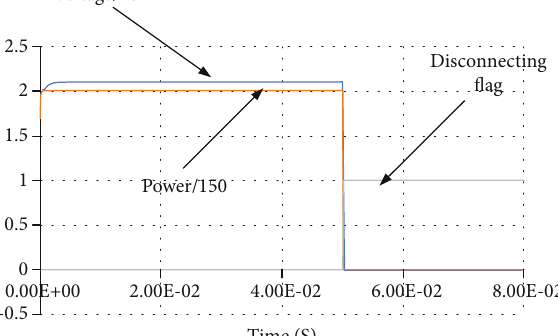
Figure 43: Disconnecting fl ag of a panel and its relevant bypass diode.